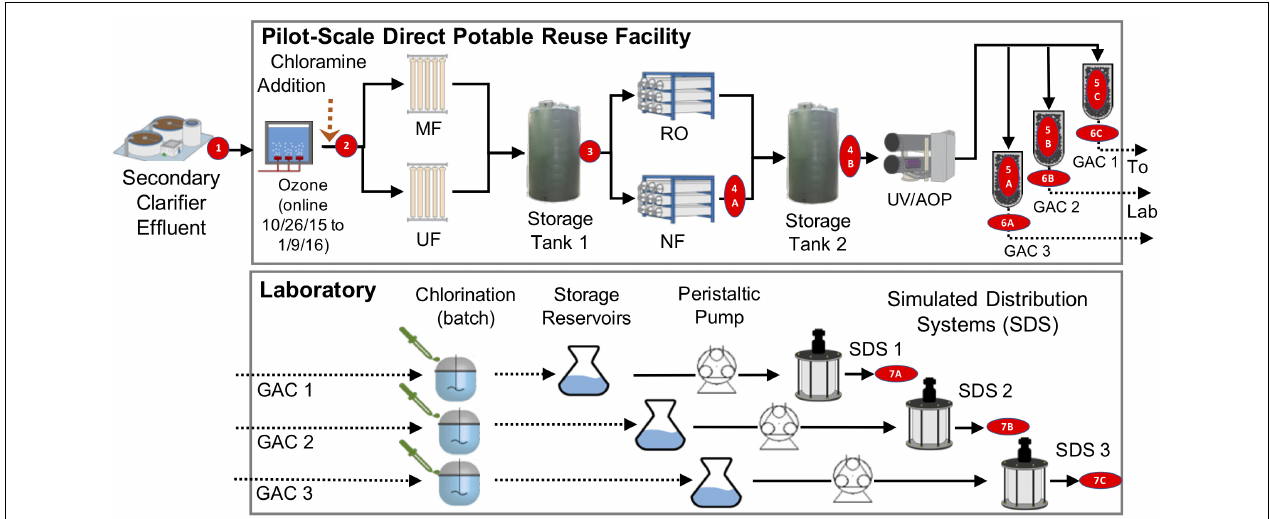
FIGURE 1 | Treatment train and experimental design. Secondary treated wastewater was fed to a pilot-scale advanced water treatment train which included parallel microfiltration (MF) and ultrafiltration (UF), parallel nanofiltration (NF), and reverse osmosis (RO), UV/advanced oxidation process (AOP), and three parallel granular activated carbon columns (see Supplementary Methods ). Distribution was modeled by three parallel flows through batch chlorination, storage, and annular reactors. Red numbers indicate sample locations corresponding to identifiers in Table 1 .